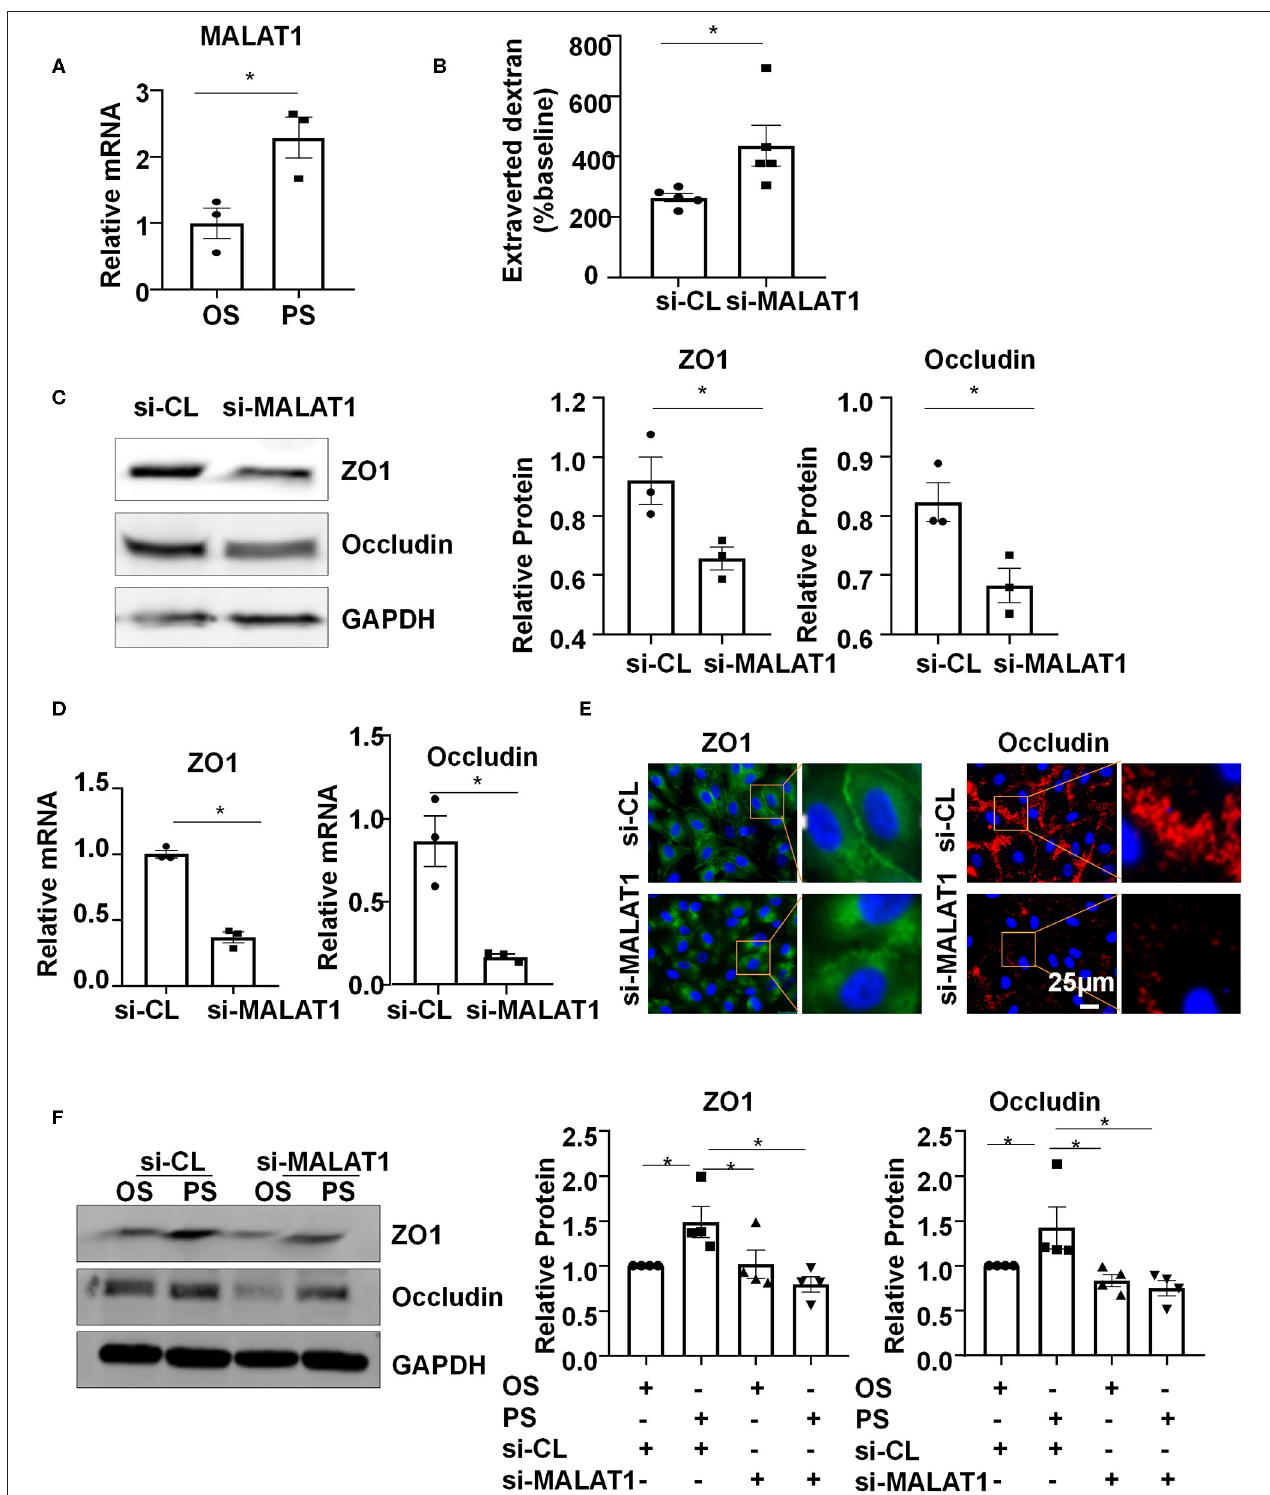
FIGURE 2 | Pulsatile shear (PS) upregulates long non-coding RNA MALAT1 to maintain the endothelial barrier function. (A) HUVECs were exposed to PS or OS for 6h, and the expression of MALAT1 was analyzed by qRT-PCR. (B) HUVECs were seeded on polycarbonate membrane in transwells, transfected with siRNAs